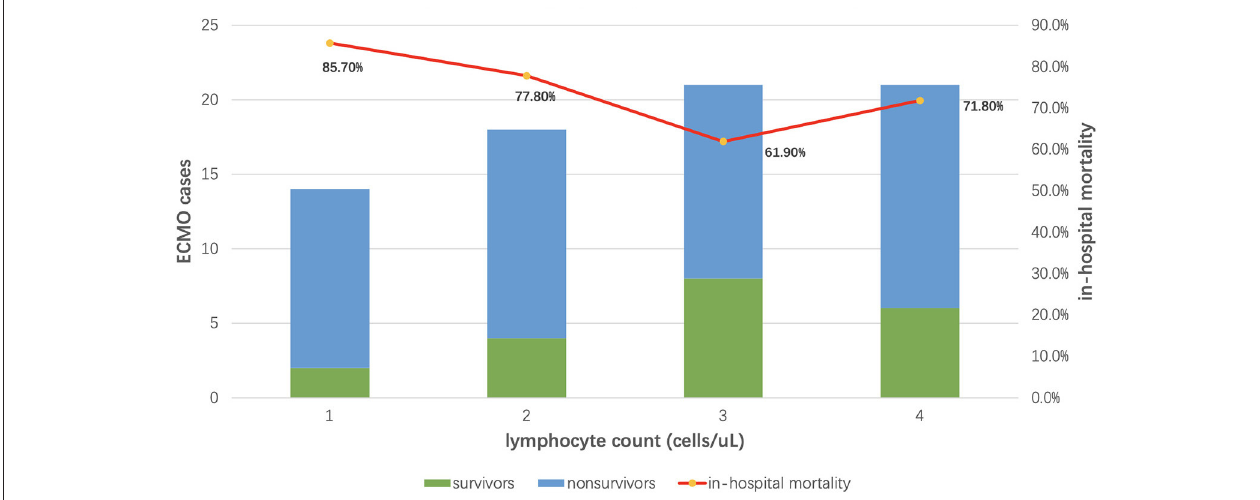
FIGURE 2 | The relationship between lymphocyte count and in-hospital mortality. The median lymphocyte counts of all the enrolled patients were 590 cells/uL. According to IQR, ECMO patients were divided into four groups. The in-hospital mortality of patients with higher lymphocyte counts was lower (in-hospital mortality from group 1 to 4: 85.7, 77.8, 61.9, and 71.8%).